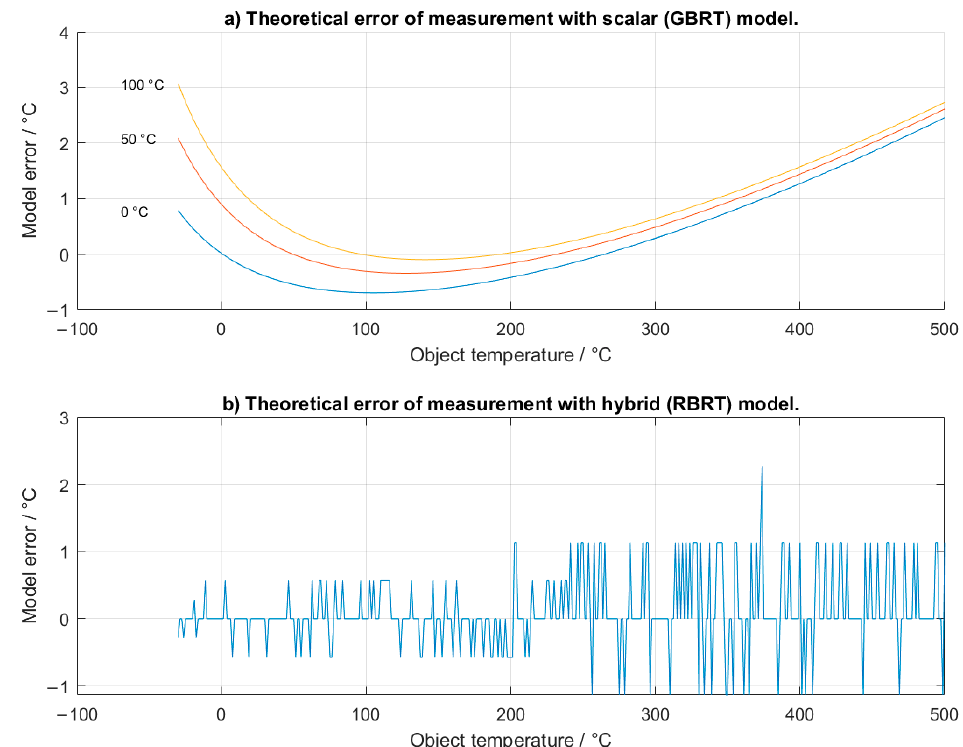
Figure 14. Theoretical error of grey body (GBRT) and real body (RBRT) radiation thermometry models, using inverse model ( a ) with constant parameters, spectrally averaged from 8 to 14 µm at various environmental temperatures; and ( b ) e ff ective parameters, weighted to the signal and the instrument in accordance with the hybrid inverse model. The model error of the hybrid model does not change with environmental temperature and can be easily further decreased by improving the resolution of the inverse characteristic function, obtained as function fi t in Figure 11.